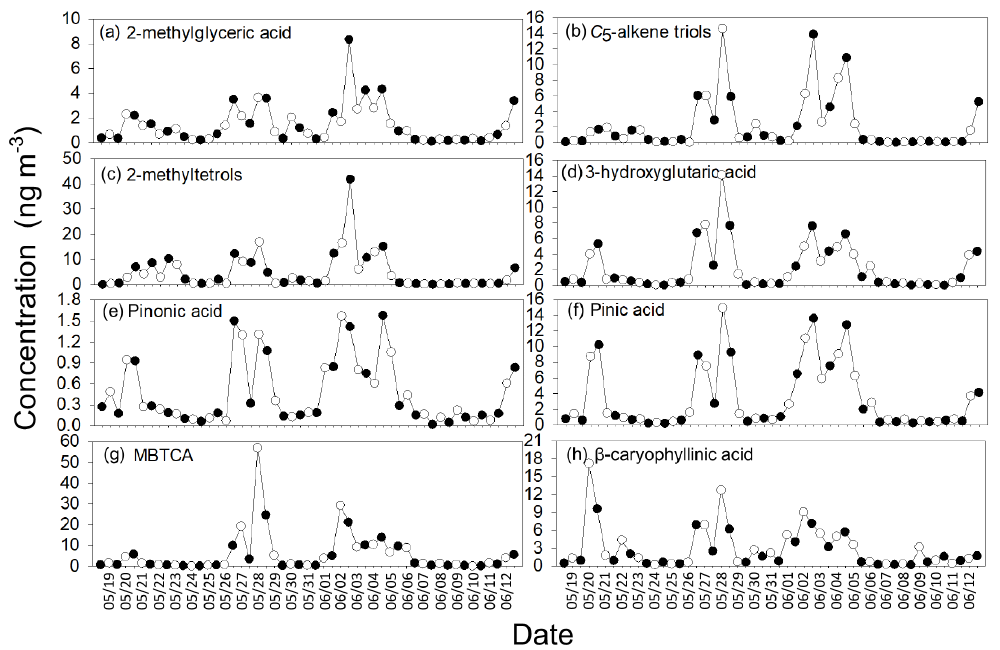
Figure 4. Temporal variations in biogenic SOA tracers detected in marine aerosols over the East China Sea during May to June 2014. The open and shaded circles represent daytime and nighttime values, respectively.